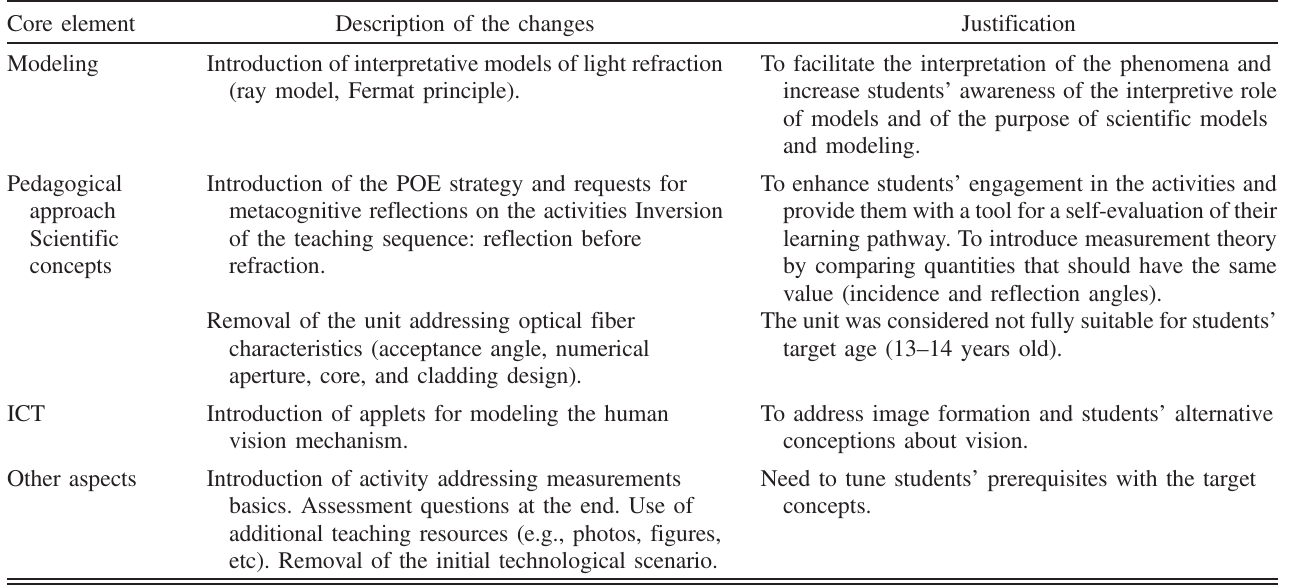
TABLE V. Changes to the core elements of the transferred TLS on optical properties of materials. Core